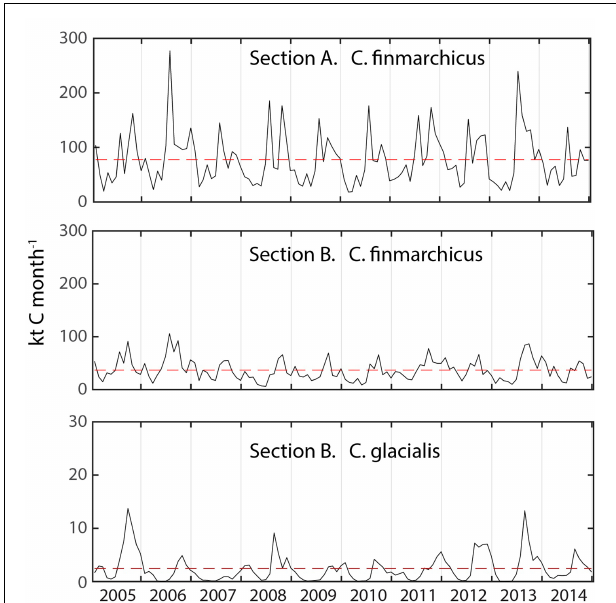
FIGURE 4 | The monthly modeled flux (kt C month − 1 ) of C. finmarchicus across sections A and B and C. glacialis through the section B from 2005 to 2015. Note scale differences and potential reversals of flux. Hatched time line shows the mean flux for the simulation period.